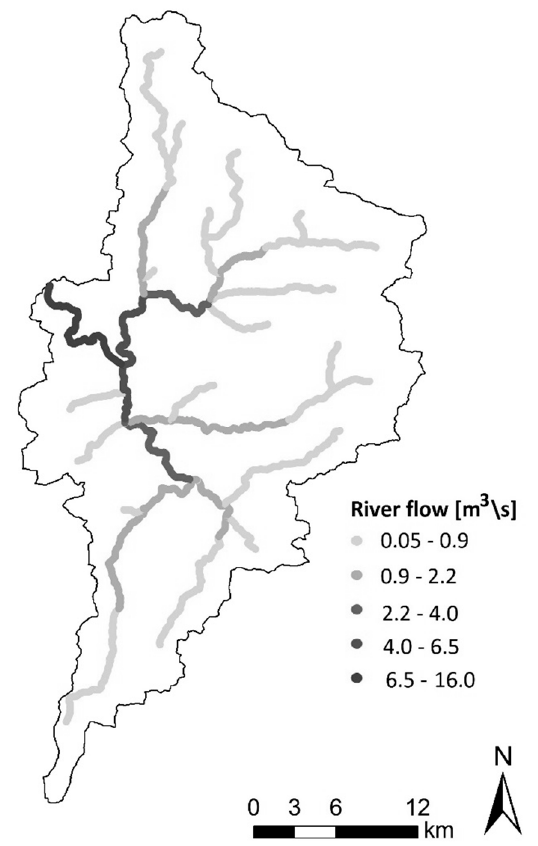
Figure 7. Simulated values of average annual river flow (m 3 /s) in each river channel.